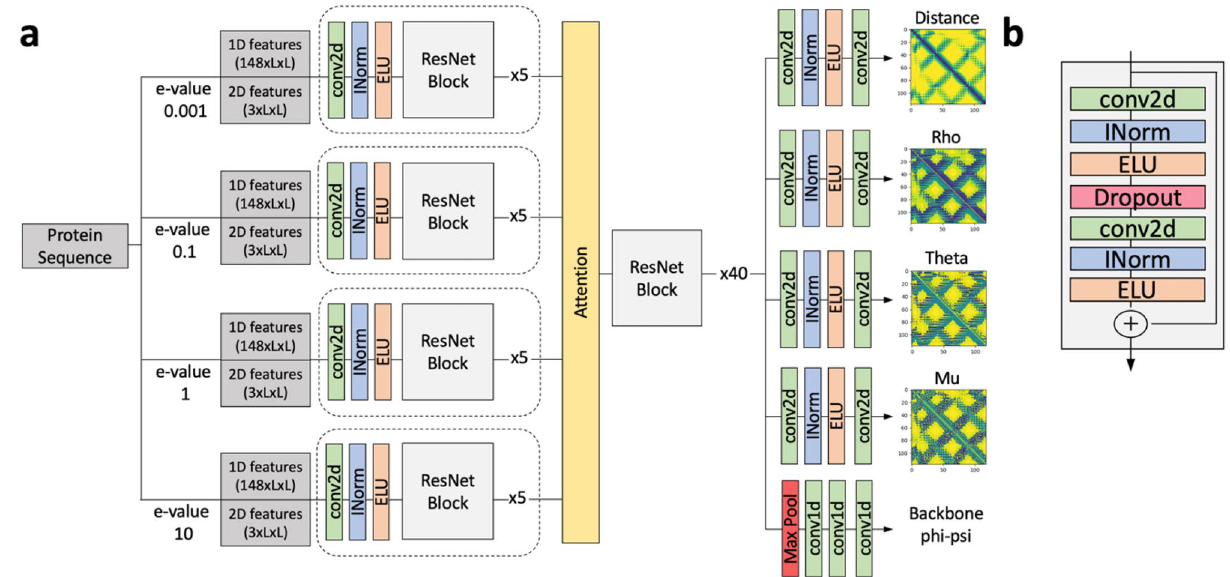
Figure 1. The network architecture of AttentiveDist. ( a ) The overall architecture. From sequence-based features computed from a set of MSA’s of different E-values and 2D features, AttentiveDist uses ResNet with attention mechanism to predict Cβ-Cβ distances, three side-chain orientation angles, and backbone φ, ψ angles.. Dotted box represents weights are shared. ( b ) Layers in a single ResNet Block. conv2d (green), 2d convolution layer; INorm (blue), instance normalization; ELU (orange), Exponential Linear